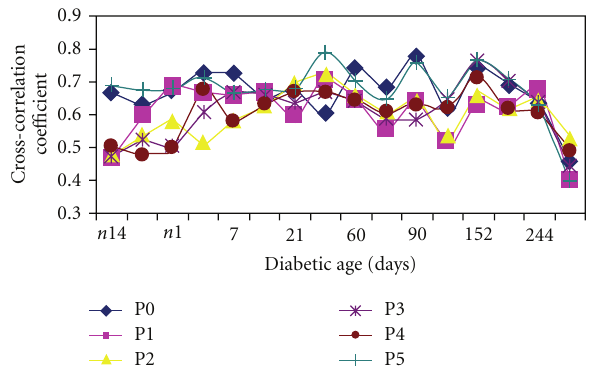
Figure 5: Graph showing longitudinal e ff ect of diabetic age on cross-correlation coe ffi cient of BP and HR in the 6 diurnal periods over the 9-month period. Values are means ± SD. ( n = 8). Note the wide di ff erences before onset of diabetes and the fall and convergence towards the last stage (273 days).